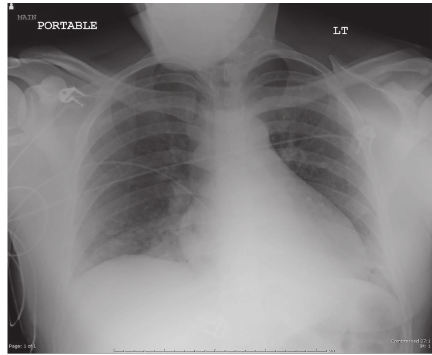
Figure 2: Right lower lung infiltrate on chest